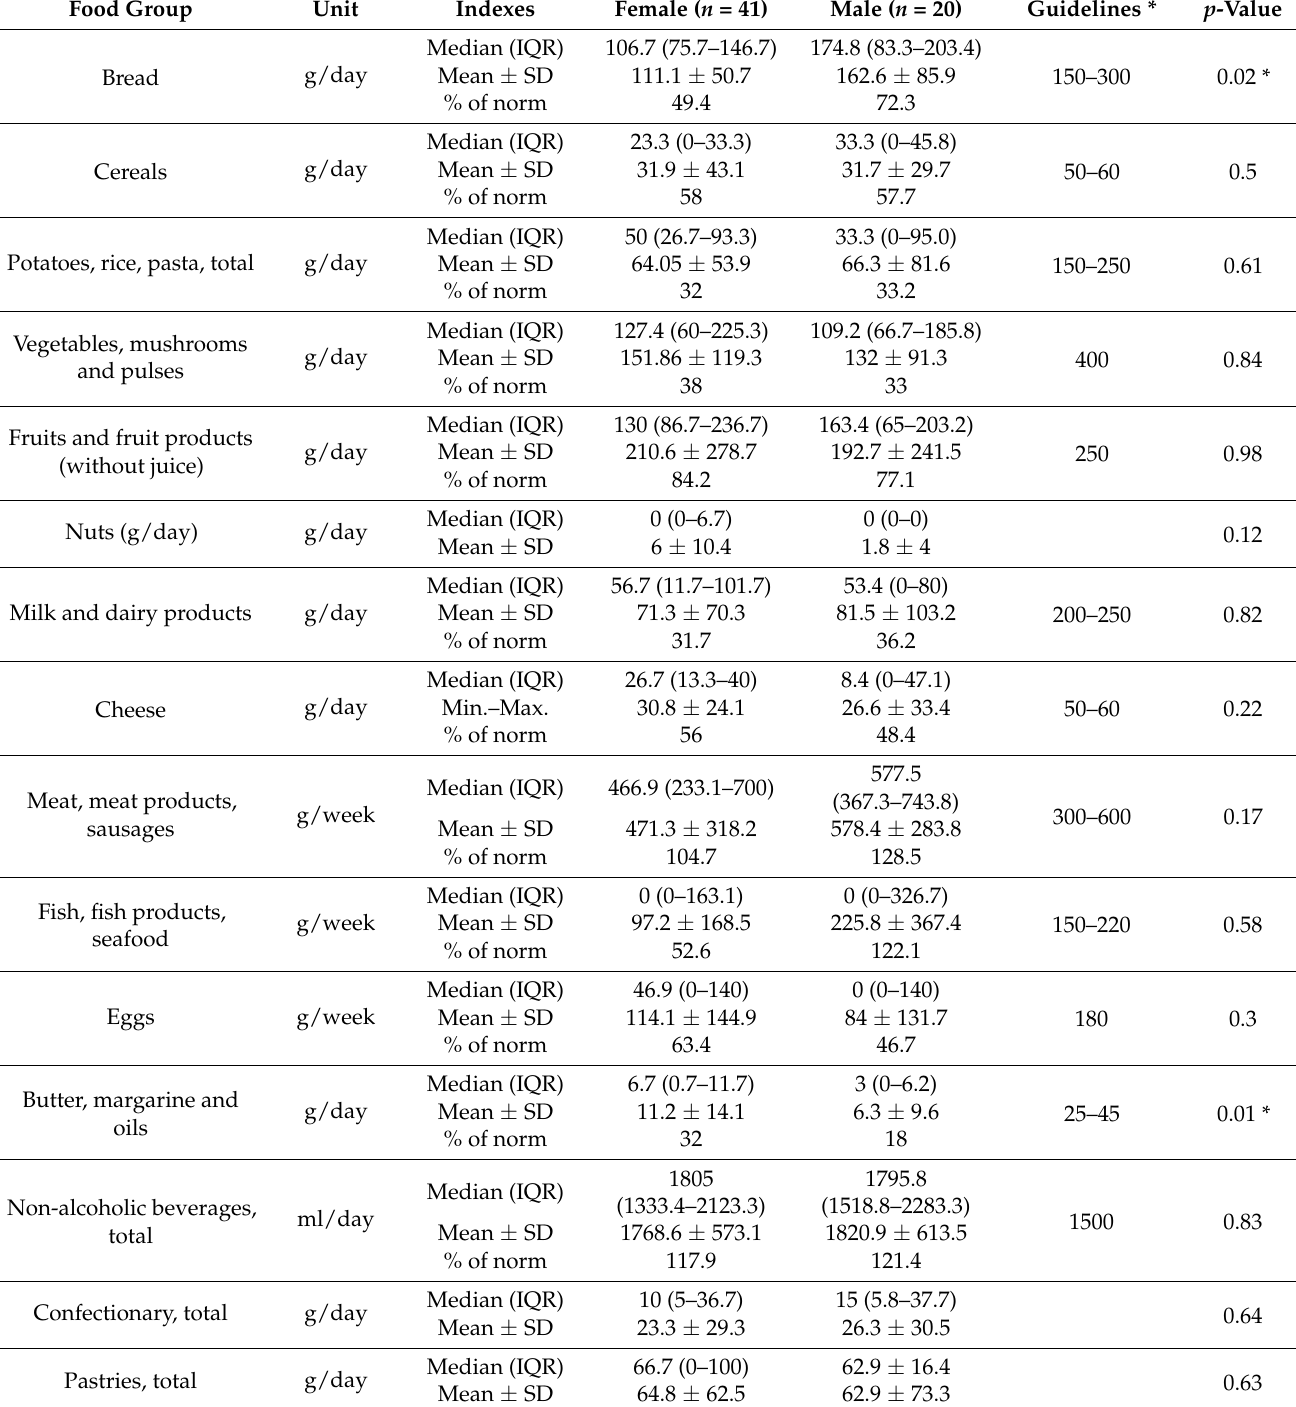
Table 6. Consumption of food groups in patients with RA ( n =